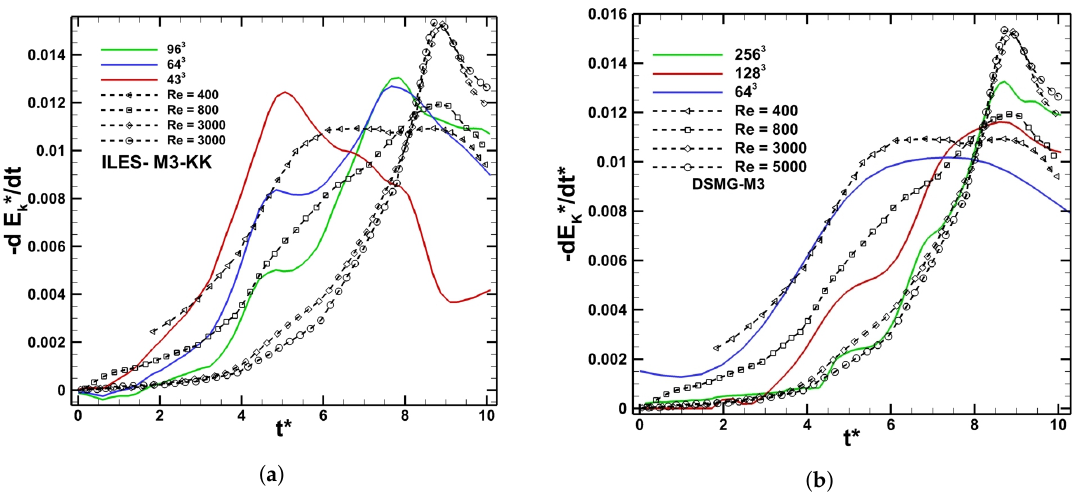
Figure 4. Evolution of the volumetrically-averaged kinetic energy dissipation obtained on all the grid levels and compared to DNS data of Brachet et al. [20,21]. ( a ) ILES, M3-KK; ( b ) LES,